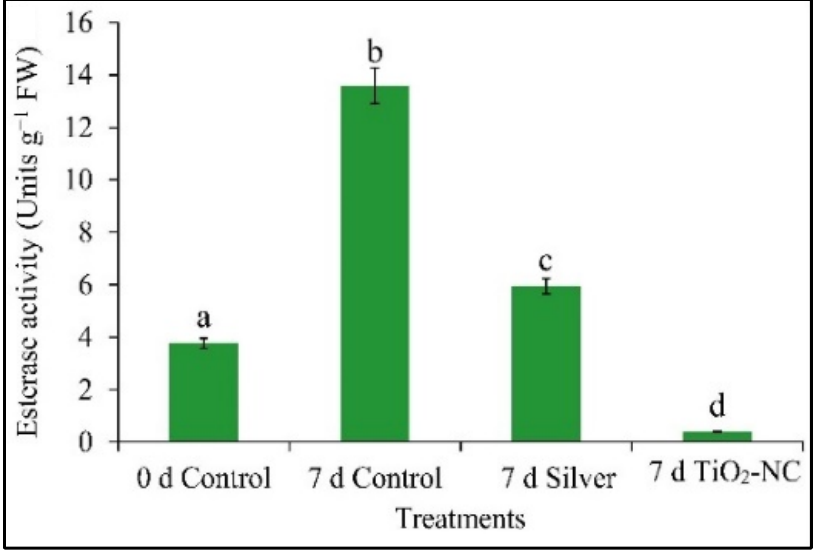
Figure 9. Activity of esterase from pulp tissues of Capsicum on tissues under silver and TiO 2 -NC treatments with respect to control (0 d) and 7 d storage of postharvest at 25 °C. Vertical bars showing SE ± 1 ( n = 3) on each column and letters above bars indicate statistical variations between treatments based on one way ANOVA ( p ≤ 0.05).